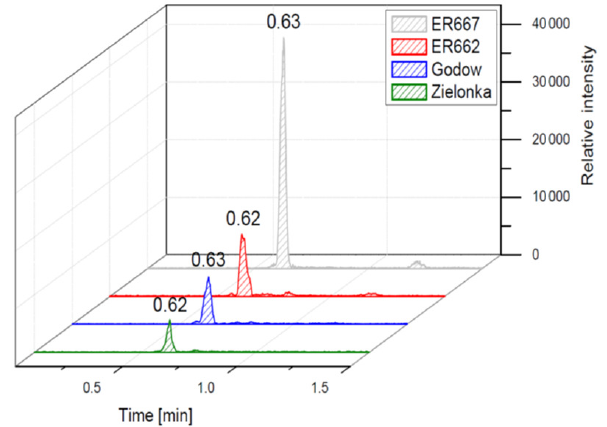
Figure 7. Extracted-ion chromatograms of 2-methylglyceric acid organosulfate with MW 200 from field studies and chamber exper-